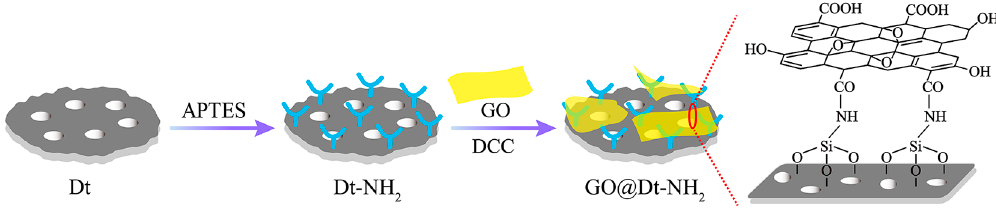
Figure 4. Schematic illustration of the fabrication of GO@Dt–NH 2 composites.